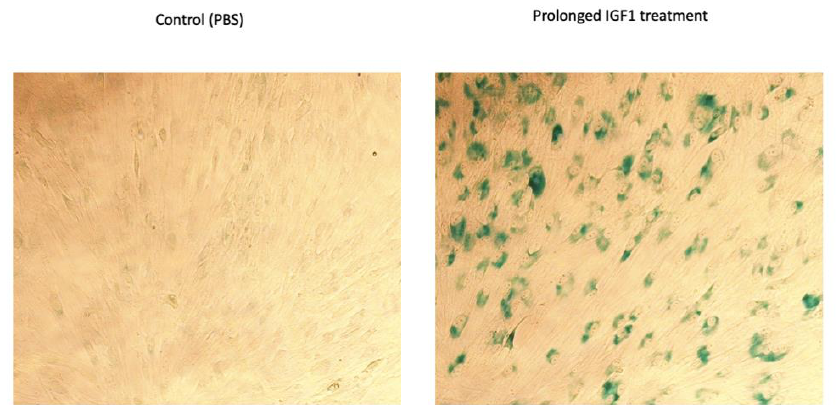
Figure 5. Analysis of β -gal staining upon prolonged IGF1-induced premature senescence. Repre- sentative images of β -gal staining in control (PBS-treated) and IGF-1 treated cells. Senescence was induced as described in Figure 4A.